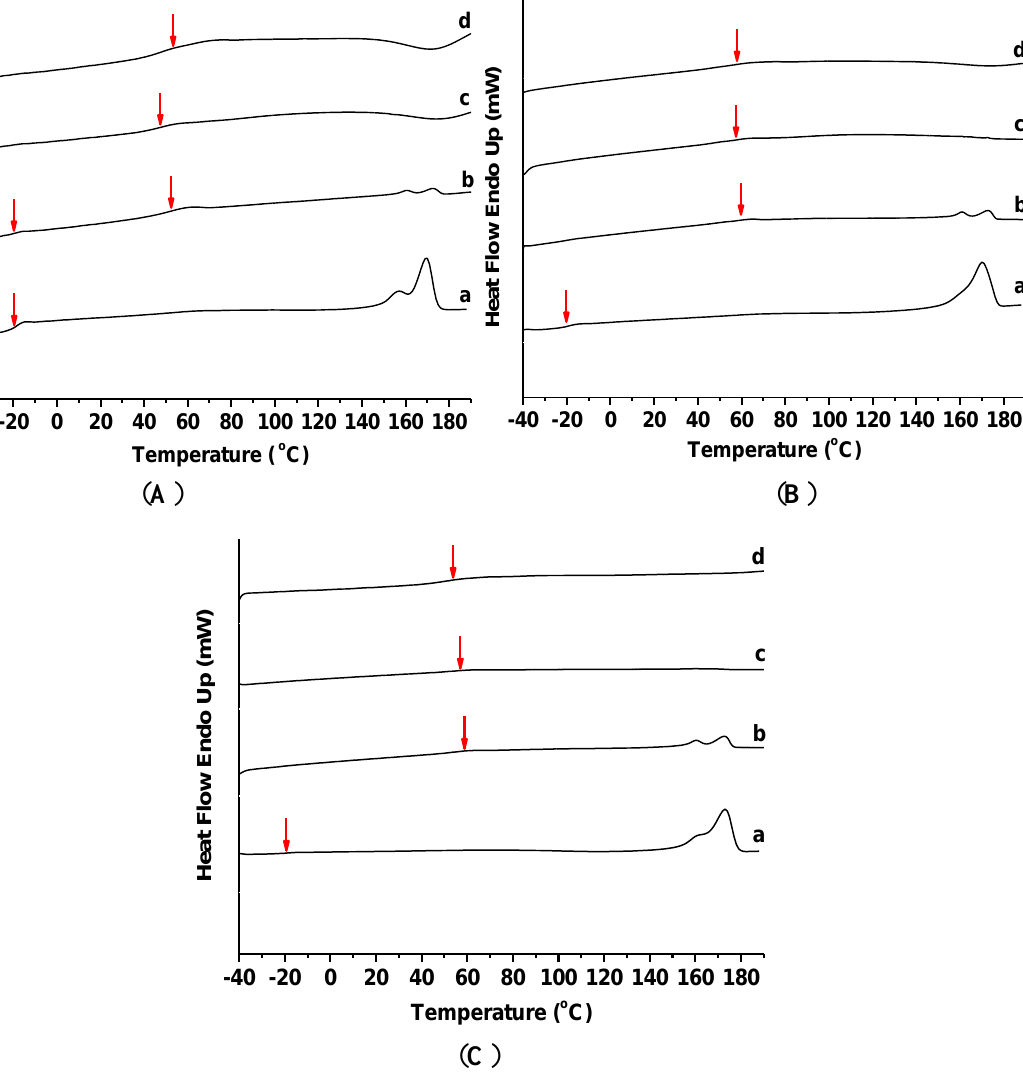
Figure 5. DSC thermograms (first heating program) of PHB/ENR-50 blend composition of ( A ) 30/70; ( B ) 50/50; and ( C ) 70/30 containing (a) 0, (b) 1, (c) 3, and (d) 5 wt%